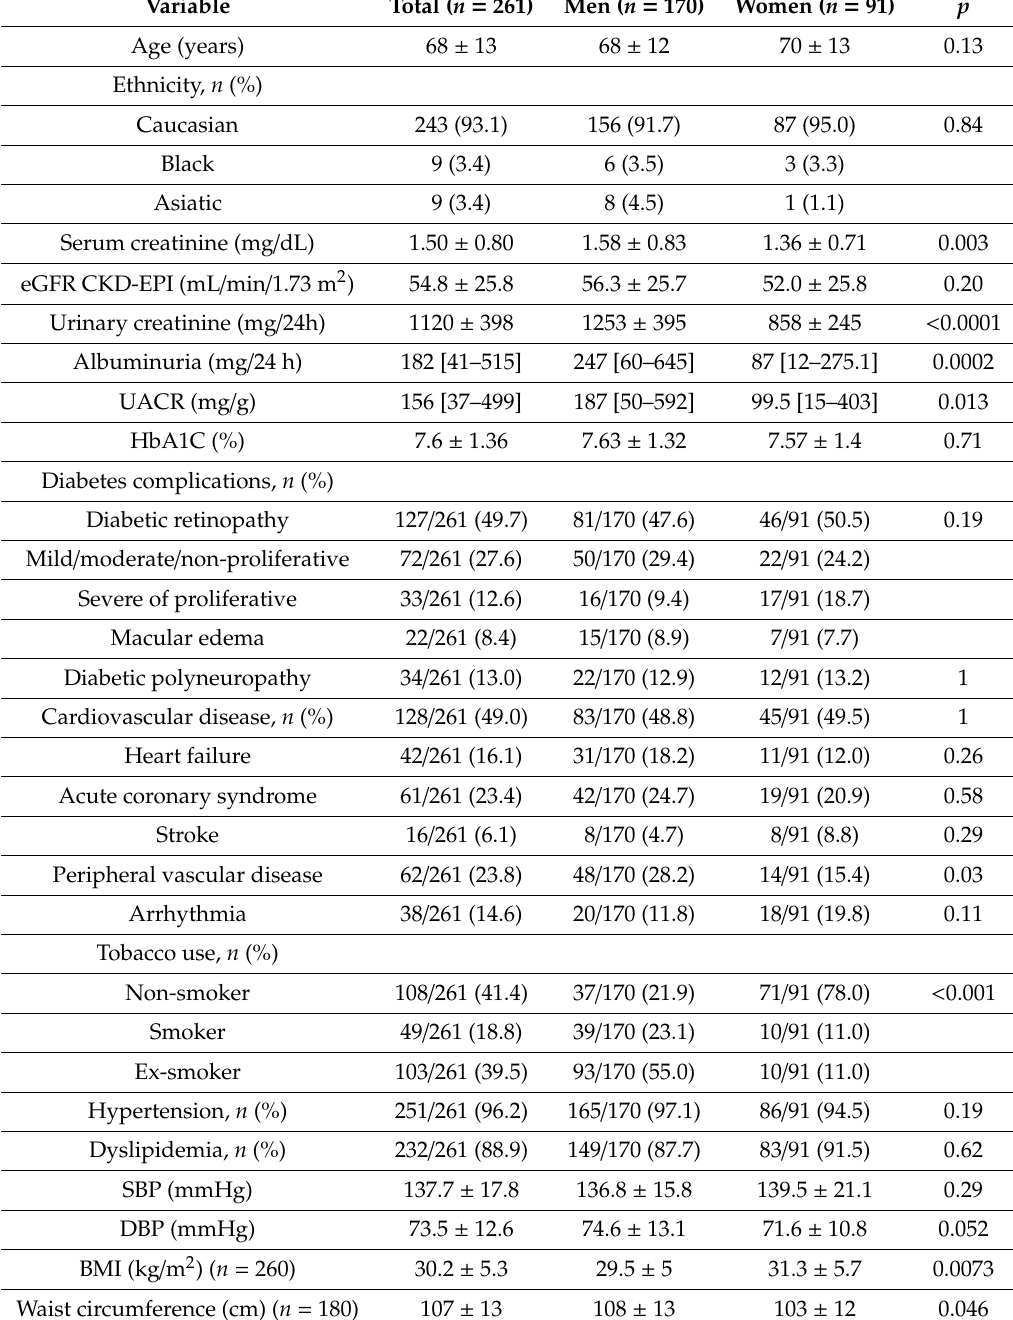
Table 1. General baseline patient characteristics. Data presented as mean ± SD, median (IQR) or n